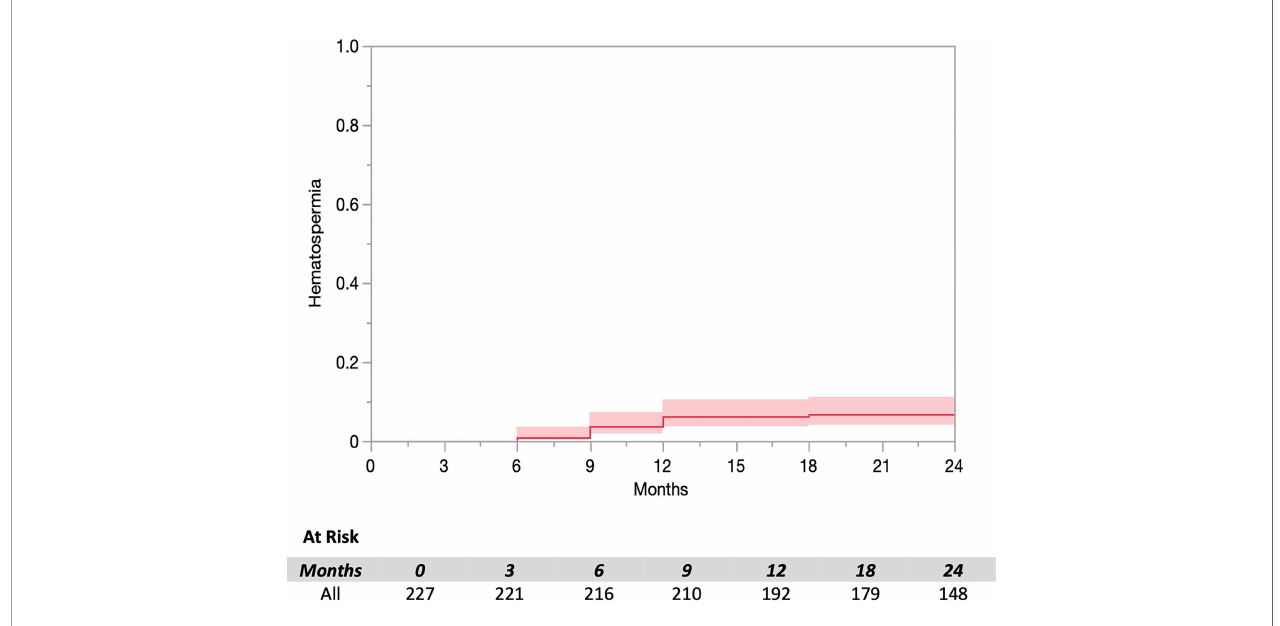
FIGURE 2 | Cumulative incidence of hematospermia following SBRT.